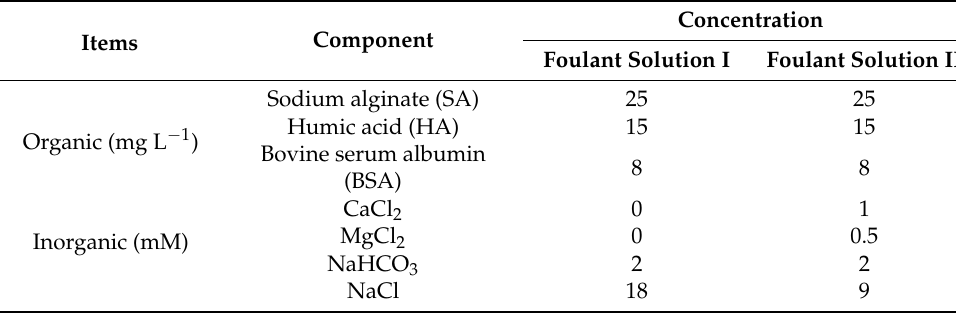
Table 1. Chemistry of two synthetic foulant solutions for antifouling filtration tests. Concentration Items Component Foulant Solution I Foulant Solution II Sodium alginate Organic (mg L − 1 )